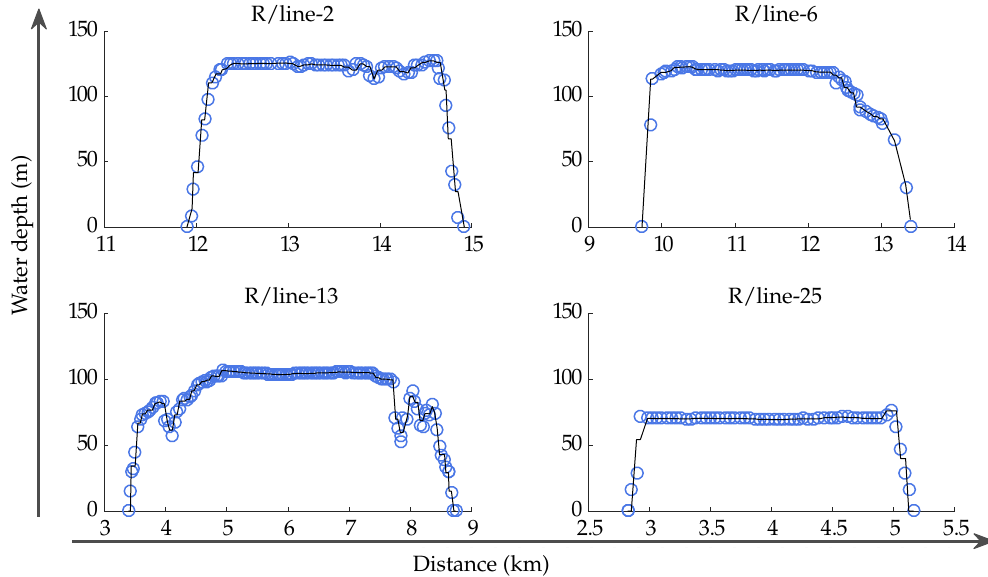
Figure 10. Comparison between measured (circles) and simulated water depths at selected cross sections (R/line) for 1983’ event. Measurements starts from the orographically left side of the reservoir.